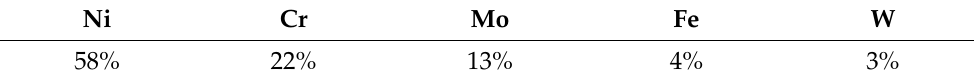
Table 1. Chemical composition (%) of corrosion-resistant